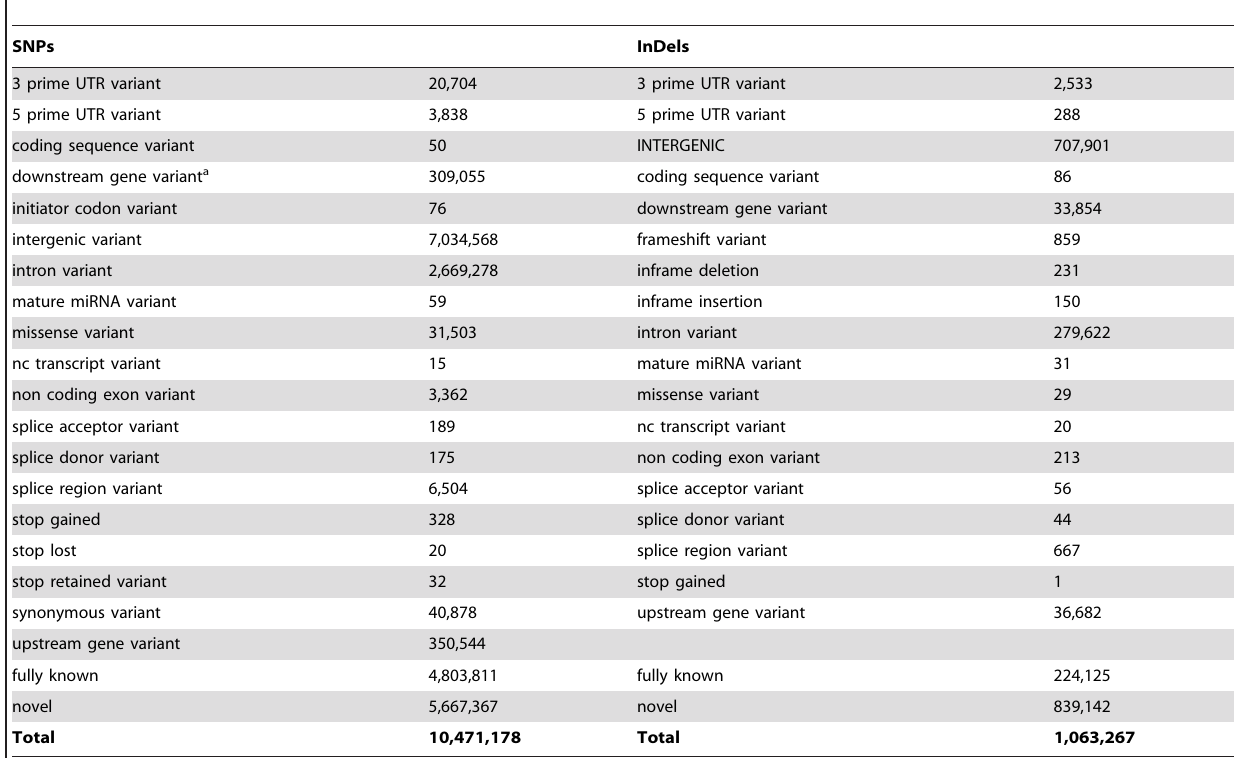
Table 2. Functional classification and novelty status of the detected single nucleotide polymorphisms (SNPs) and insertion– deletions (InDels).